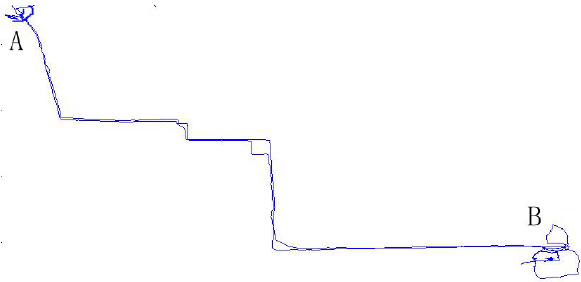
Figure 2. An example of a trajectory in real world The distance function used in clustering line segments consists of two parts: (1) spatial distance ( ds ); (2) temporal distance ( dt ). The data model of sub-track segments is